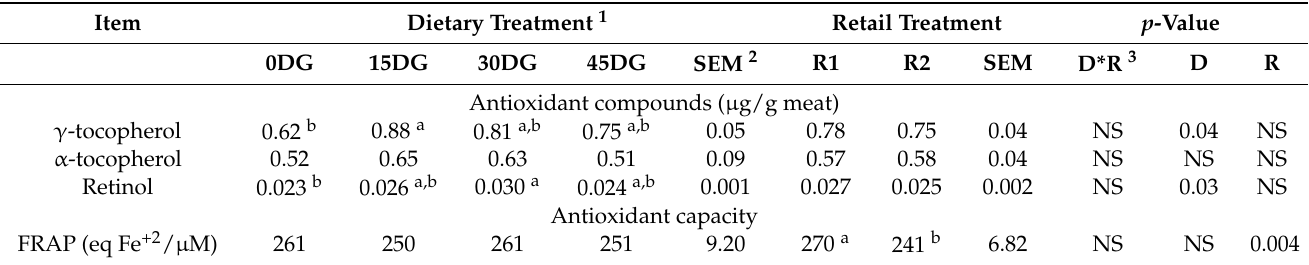
Table 4. Content of antioxidant vitamins and antioxidant stability in LTL muscle at the end of each storage and retail display